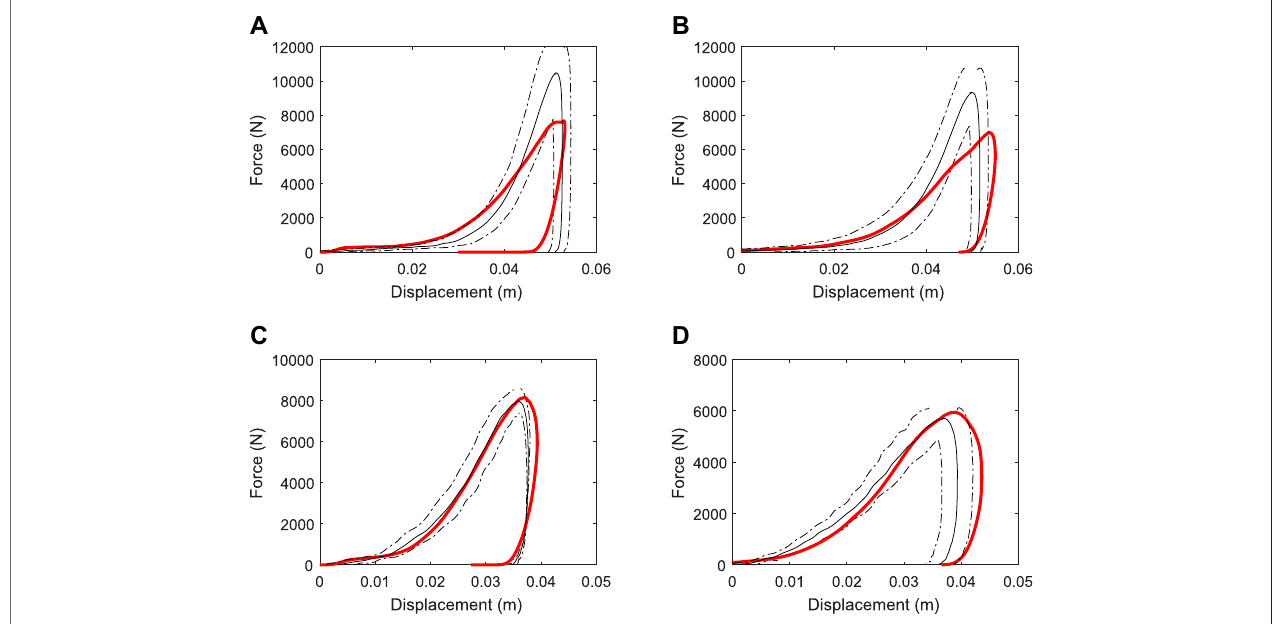
FIGURE 9 | Variation of force-time results for simulations using the calibrated material parameters of the (A,B) dirt, and (C,D) synthetic tracks. Results for the verticalimpactareshownintheleftcolumn(A,C)andforthe20 ° fromverticalimpactareshownintherightcolumn(B,D).Theexperimental dataisshownasmean(solid black line) ± standard deviation (dashed black lines) and the simulation data is shown as a red solid line.